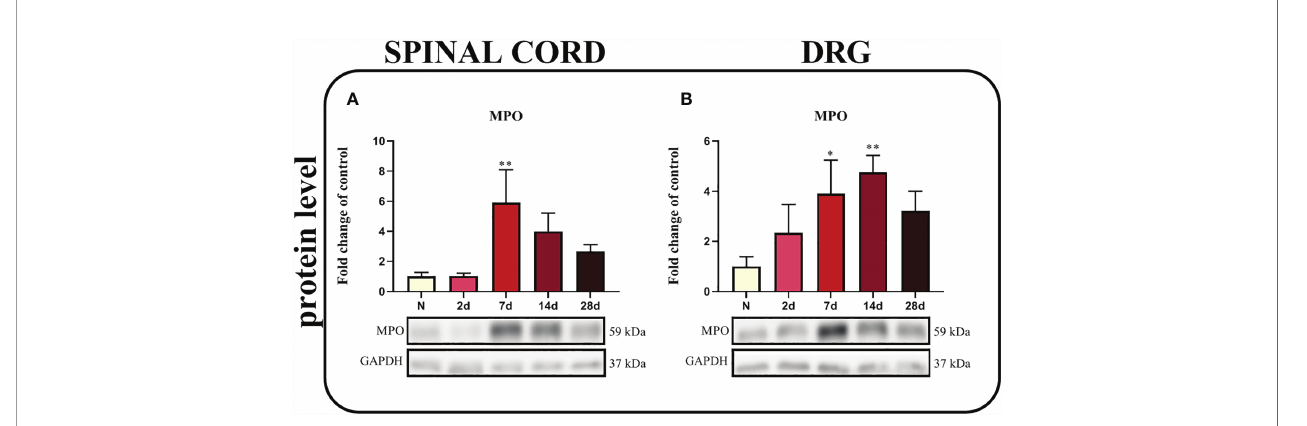
FIGURE 9 | Time-dependent changes in the level of the MPO protein in the rat spinal cord (A) and DRG (B) on the 2 nd , 7 th , 14 th and 28 th days after chronic constriction injury of the sciatic nerve (CCI). The biochemical data are presented as the mean fold changes relative to the control ± SEM (4 – 5 samples per group). Intergroup differences were analyzed using ANOVA with Bonferroni ’ s post hoc test for multiple comparisons. *P < 0.05 and **P < 0.01 indicate a signi fi cant difference compared with the control group (naive, N